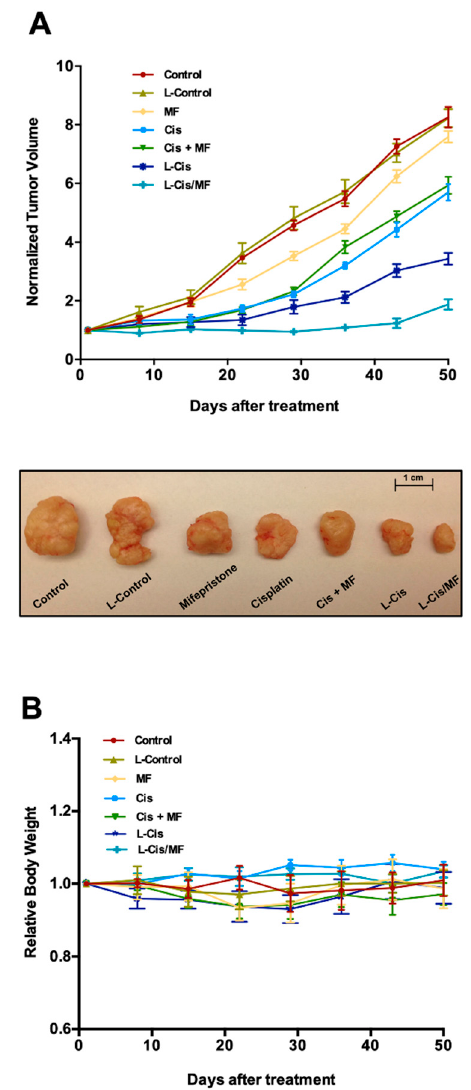
Figure 6. ( A ) Efficacy of the distinct treatments on mice with HeLa cell xenografts: non-encapsulated drugs (cisplatin, mifepristone and the combination of Cis/MF), drug-loaded liposomes (L-Cis and L-Cis/MF), and the corresponding controls: no treatment (control) and empty liposomes (L-Control). tumors reached 150 mm 3 (day 0). ( B ) Final body weight of mice in the di ff erent groups. Data are HeLa cells were implanted s.c. in the flank of nude mice. The treatments were initiated when the expressed as the mean ± standard error of the mean (SEM) of 5 animals per tumors reached 150 mm 3 (day 0). ( B ) Final body weight of mice in the different groups. Data are expressed as the mean ± standard error of the mean (SEM) of 5 animals per group.